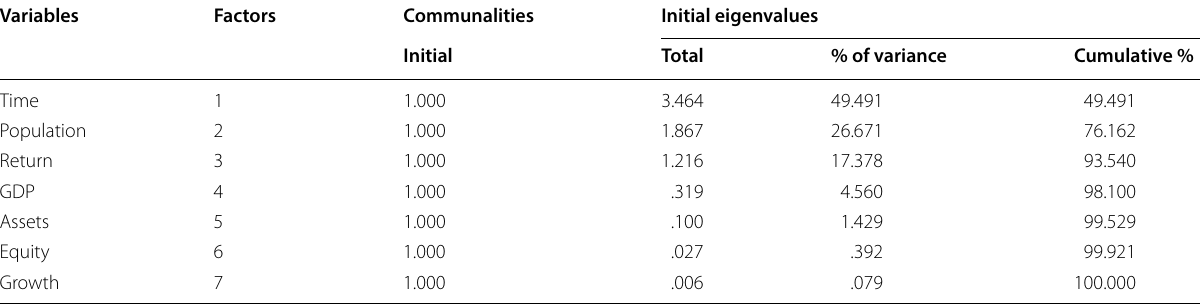
Table 3 Total variance using principal component